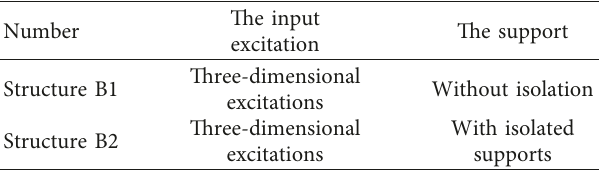
Table 1: Details of the test